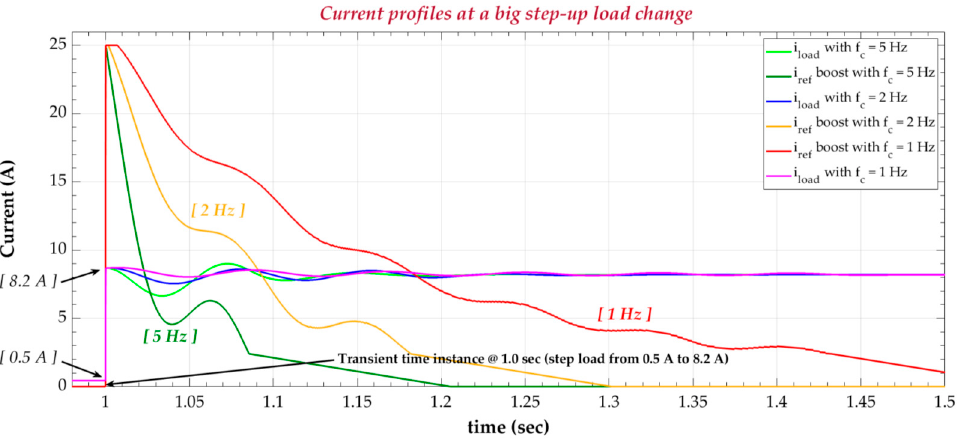
Figure 10. Load current and inductor current reference for a voltage sag case, with LPF cutoff frequency as a parameter.